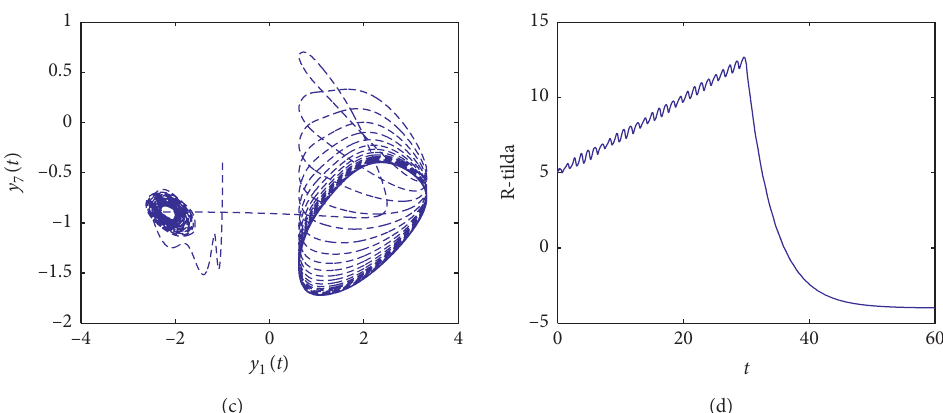
Figure 6: Adaptive control of the fixed point regime of the slave system at R time t � 30. (a) The L the slave system y